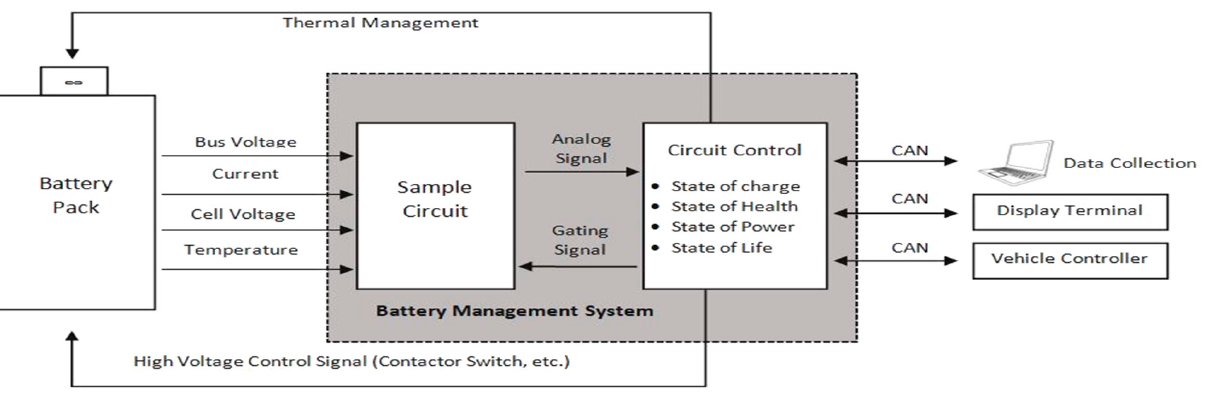
Figure 1. A general diagram of a BMS [22].